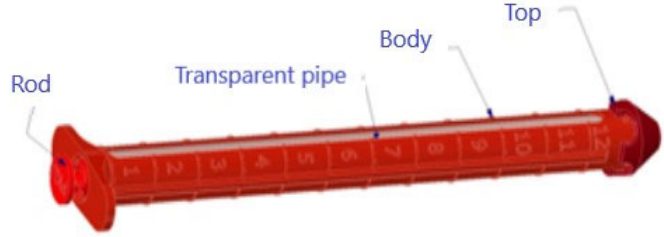
Figure 1. The component elements of the dispenser.